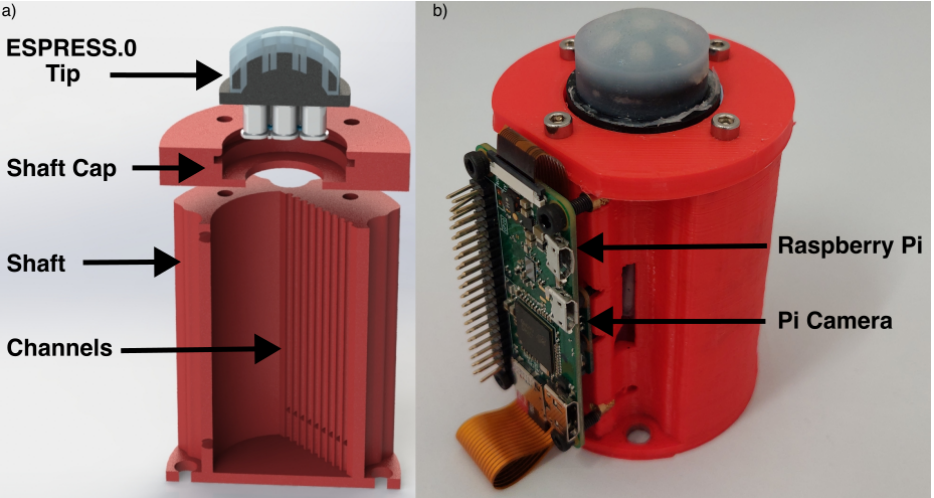
Figure 3. The untethered ESPRESS.0’s channels are concealed in an LED-lit shaft, and the data is streamed by a Raspberry Pi via WIFI. ( a ) Exploded CAD cross-section showing concealed channels. ( b ) Untethered